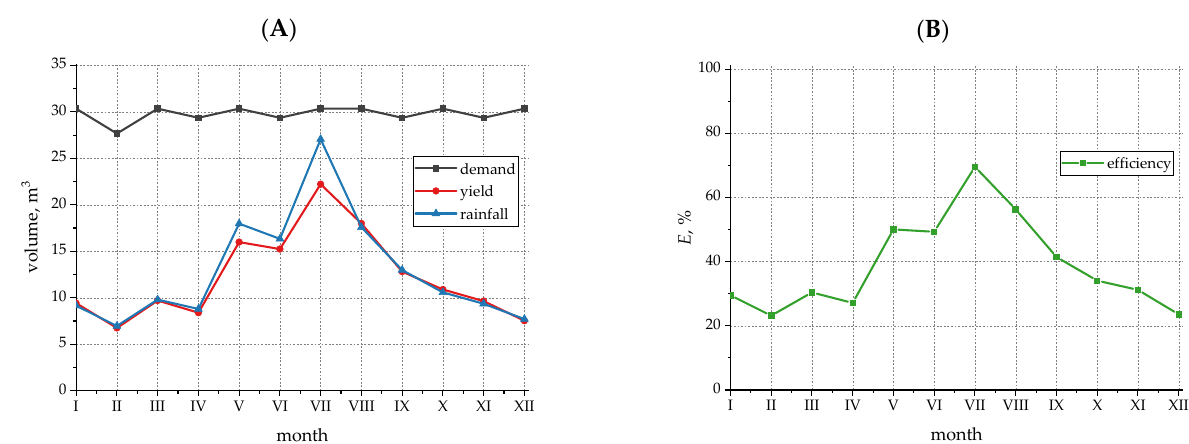
Figure 6. Mean monthly characteristics of individual rainwater recovery system. For tank capacity S = 12 m 3 . ( A ) Water demand, rainfall volume, and yield. ( B ) Monthly variation of system efficiency.